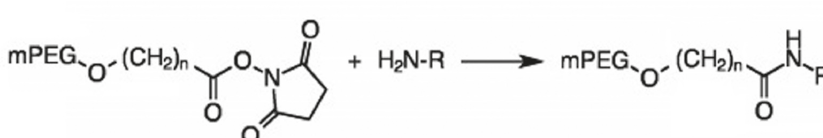
FIGURE 5 - PEGylation of primary amines in proteins, forming an amide